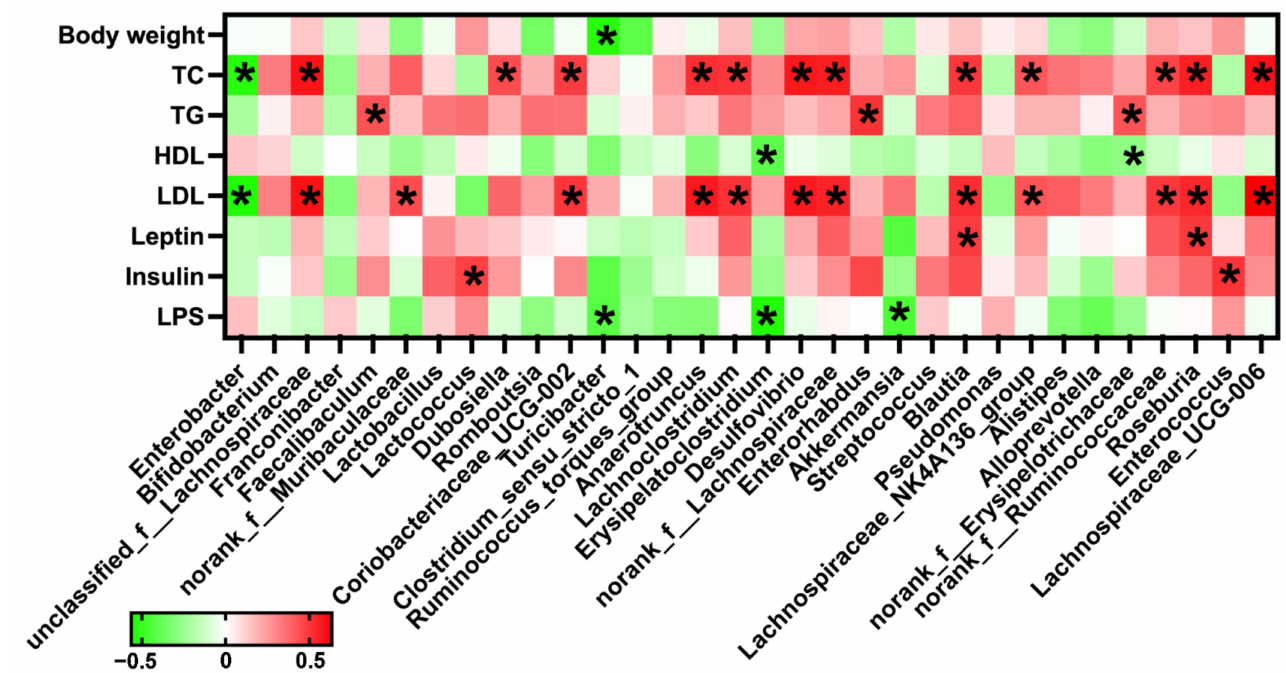
Figure 10. Heatmap result of Spearman correlation between the alterations in the fecal microbial population and the changes in serum lipid metabolic parameters. * p < 0.05 were significantly negative (green) or positive (red) Spearman